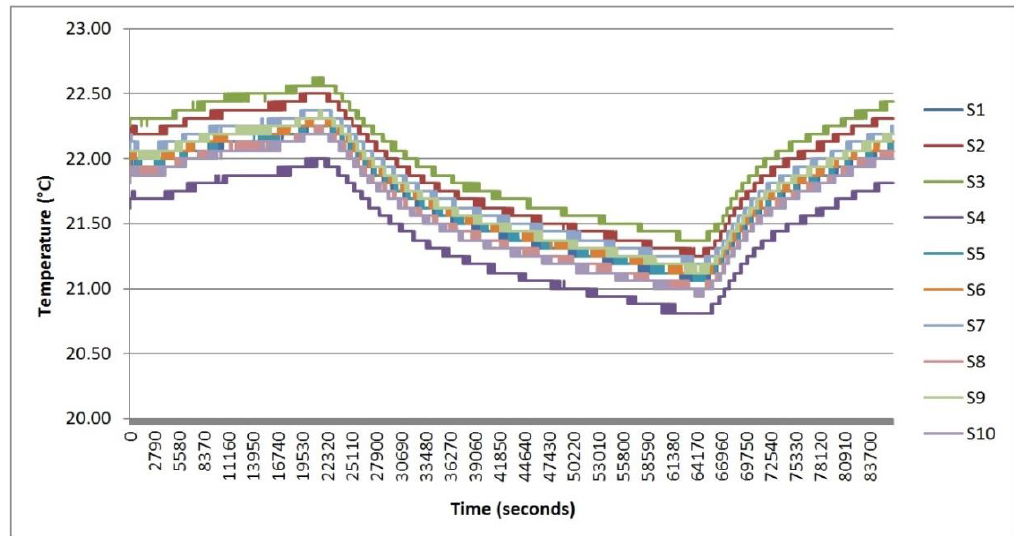
Figure 6. Temperature sensors measuring in a common ambient for the corresponding calibration.